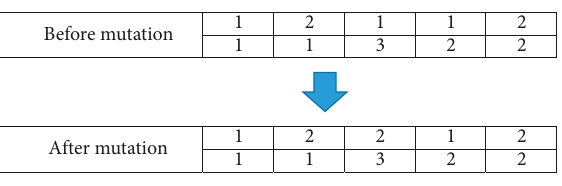
Figure 3: An example of the mutation operator.